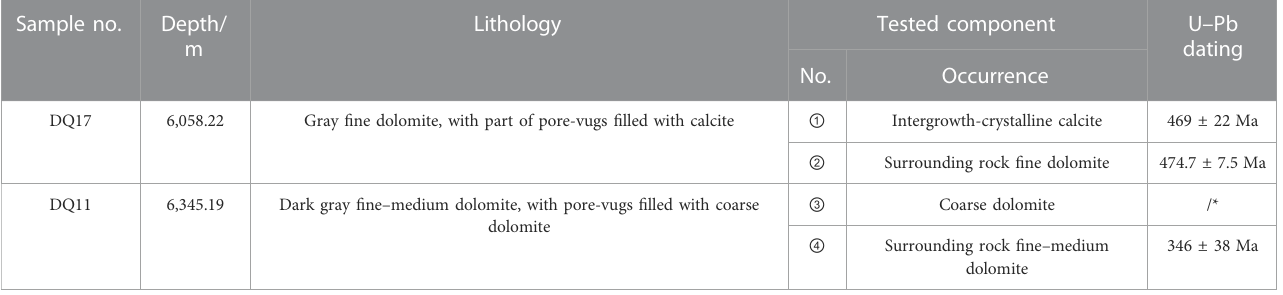
TABLE 2 Components of tested samples and results of the laser in situ U – Pb dating. Sample